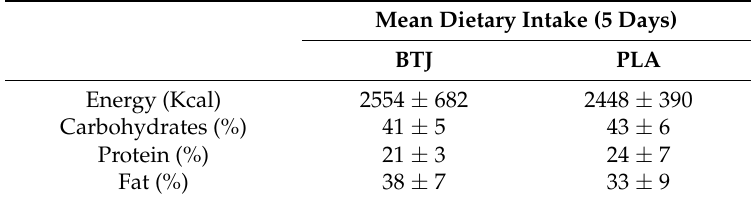
Table 3. Average intake and macro nutrient composition of participants diets (average of 5